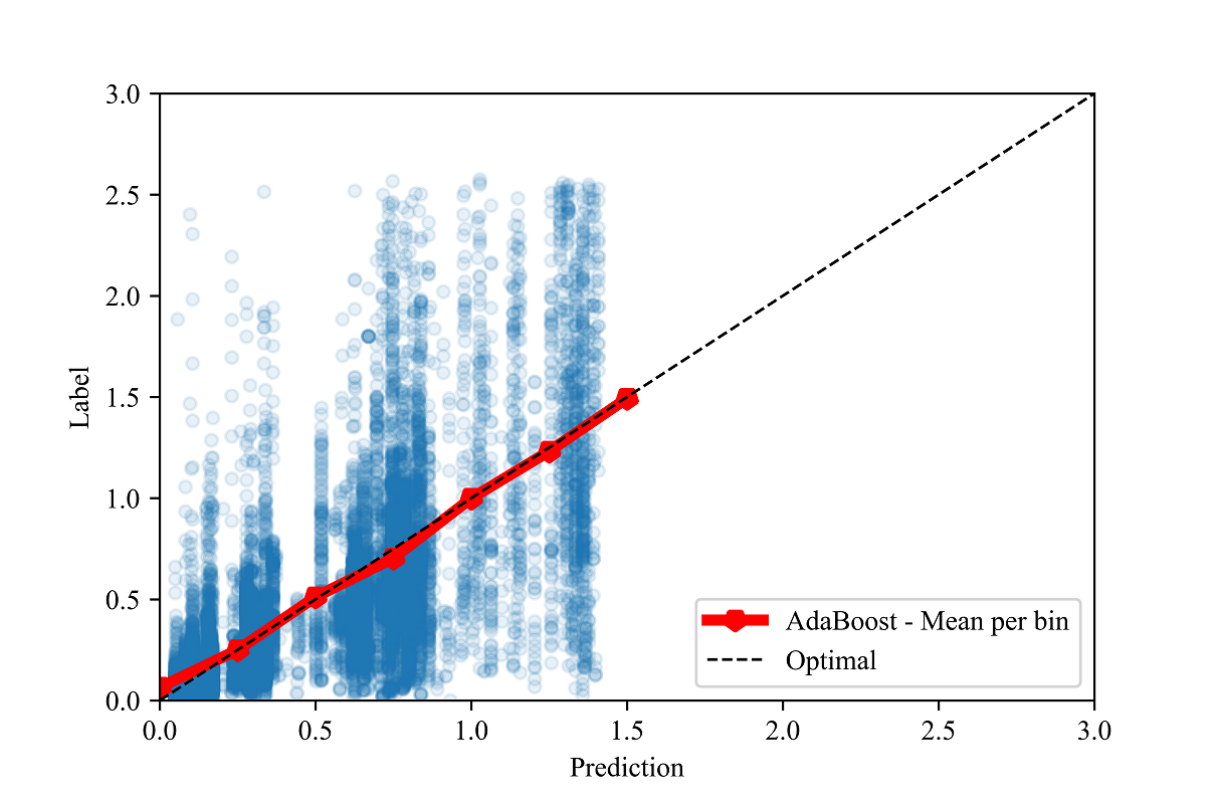
Figure 4. Calibration plot between the labels and predictions for the cross-validation method, with the mean of each prediction bin of size